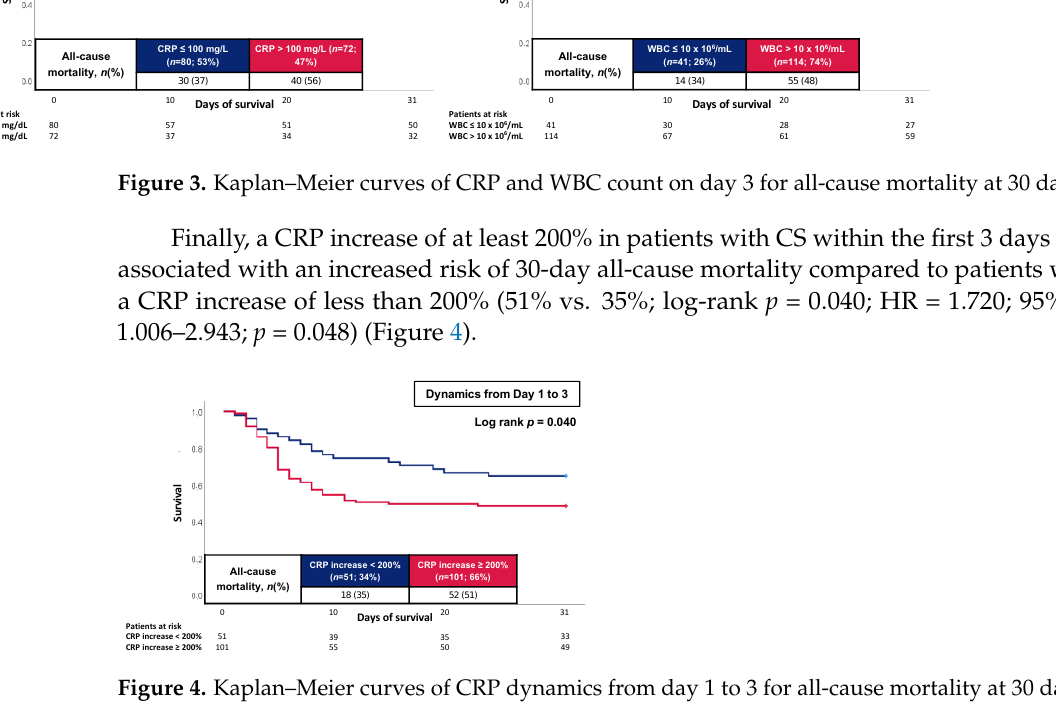
Table 5. Uni- and multivariate Cox regression analyses on day 1 within the entire study cohort with regard to 30-day all-cause mortality.